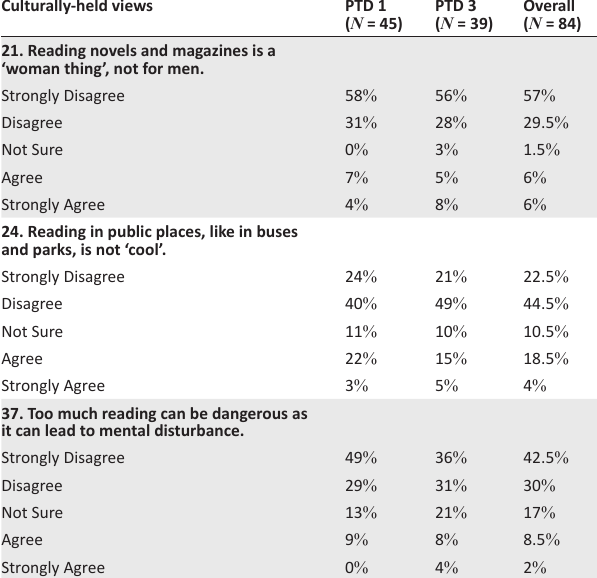
TABLE 3: Culturally-held views about extensive reading. Culturally-held views